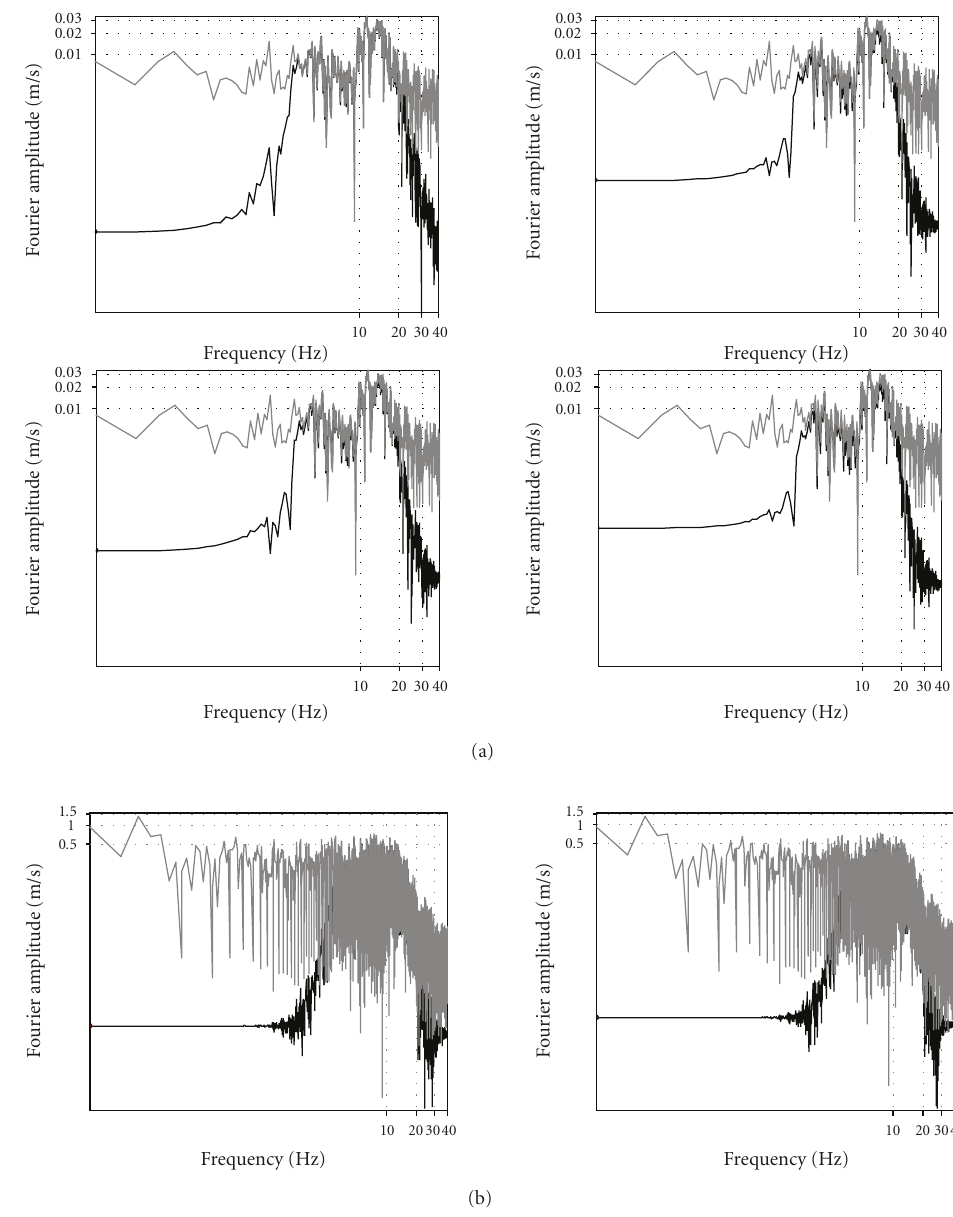
Figure 4: (a) Fourier spectra of acceleration for bandpass Chebyshev filtered Kusadasi record between 3.5Hz and 18 Hz for N = 4, V component with Rp = 0.2 dB and 1.1dB (left column), and Rp = 2 dB and 3 dB (right column). Note: the graphics in gray color show the uncorrected records. (b) Fourier spectra of acceleration for bandpass Chebyshev filtered Izmit record between 0.12 Hz and 20Hz for N = 4, V component with Rp = 1.2 dB (left) and 3dB (right). Note: the graphics in gray color show the uncorrected